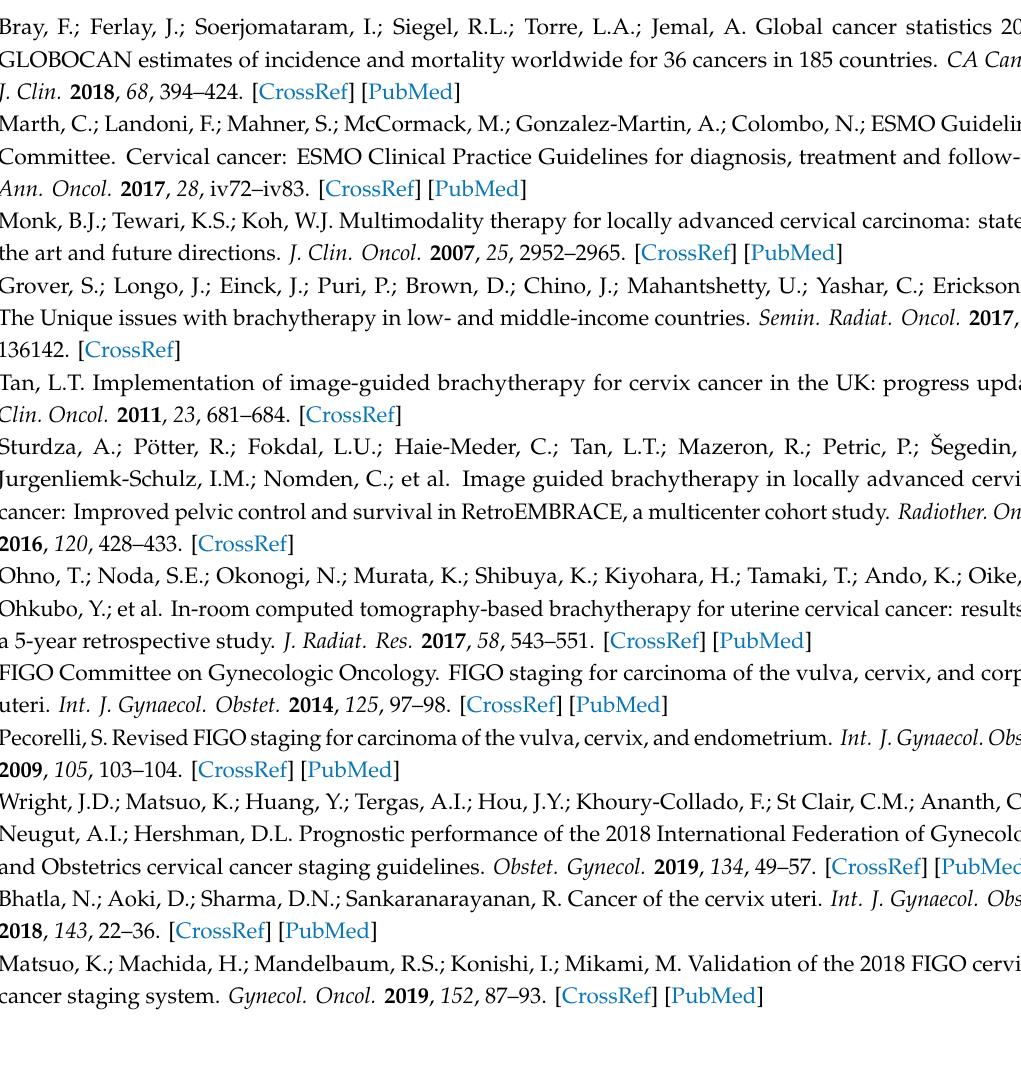
Figure S1: Kaplan–Meier estimates of overall survival (OS) ( A ) and progression-free survival (PFS) ( B ) for stage IIIC2 r patients with squamous cell carcinoma of the cervix according to the International Federation of Gynecology and Obstetrics (FIGO) 2018 staging criteria stratified by T stage based on the classification of the Union for International Cancer Control, 7th edition. p values calculated from the log-rank test for trend are